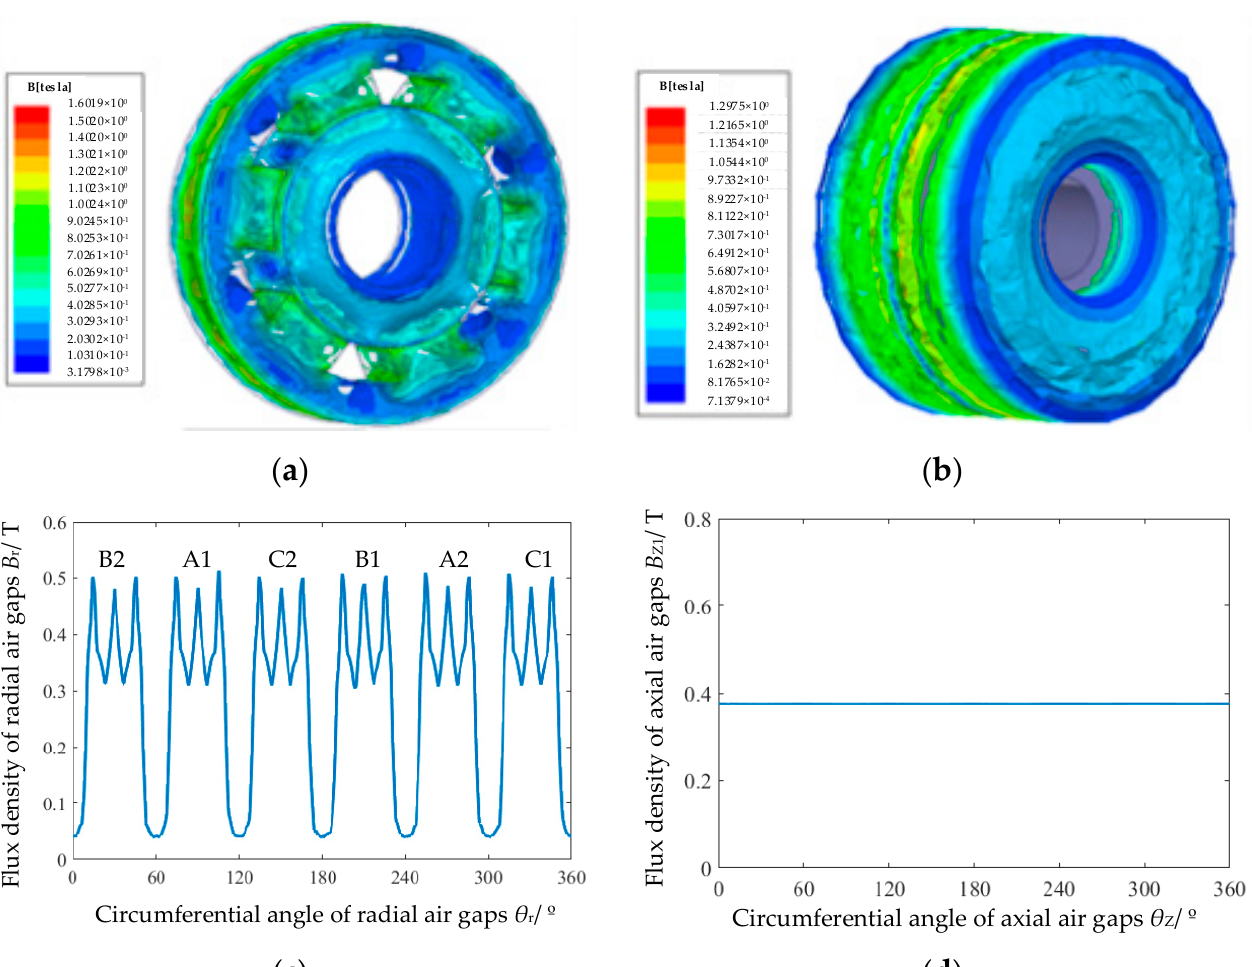
Figure 6. FE analysis results of radial and axial biased flux density. ( a ) Flux distribution of radial stator and rotor. ( b ) Flux distribution of axial stator. ( c ) Flux density in radial air gaps. ( d ) Flux density in axial air gaps.